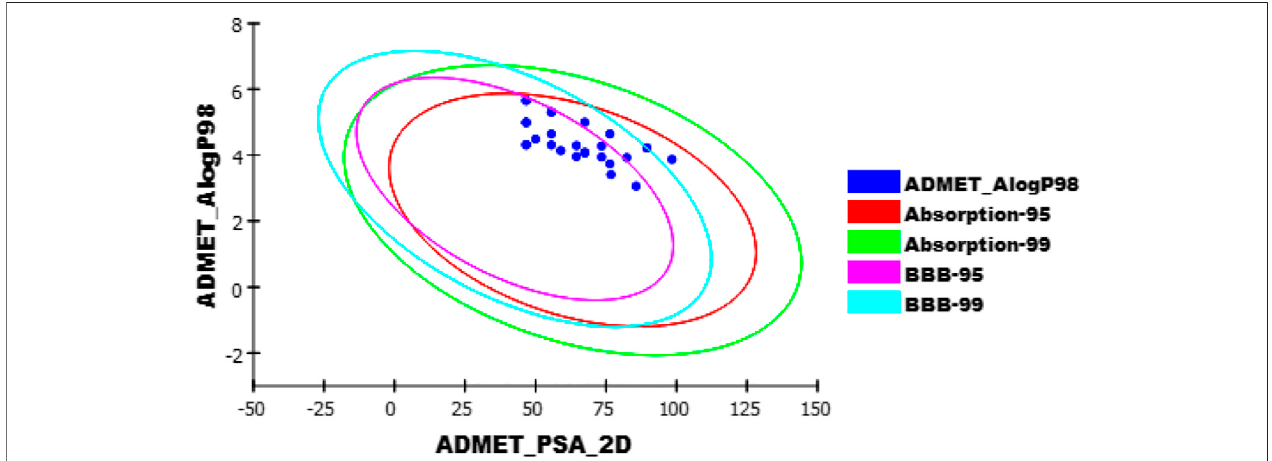
FIGURE 10 | The expected ADMET study for the newly synthesized quinoxaline